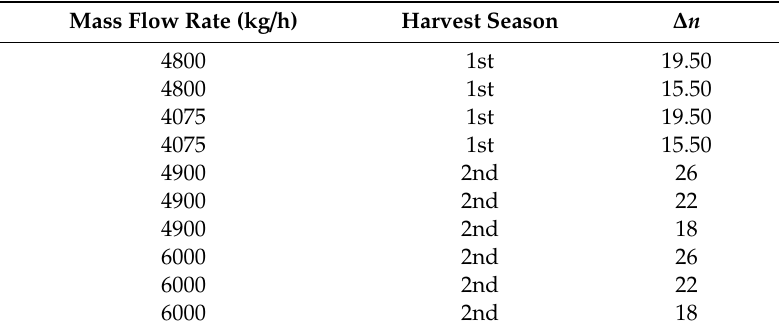
Table 2. Experimental